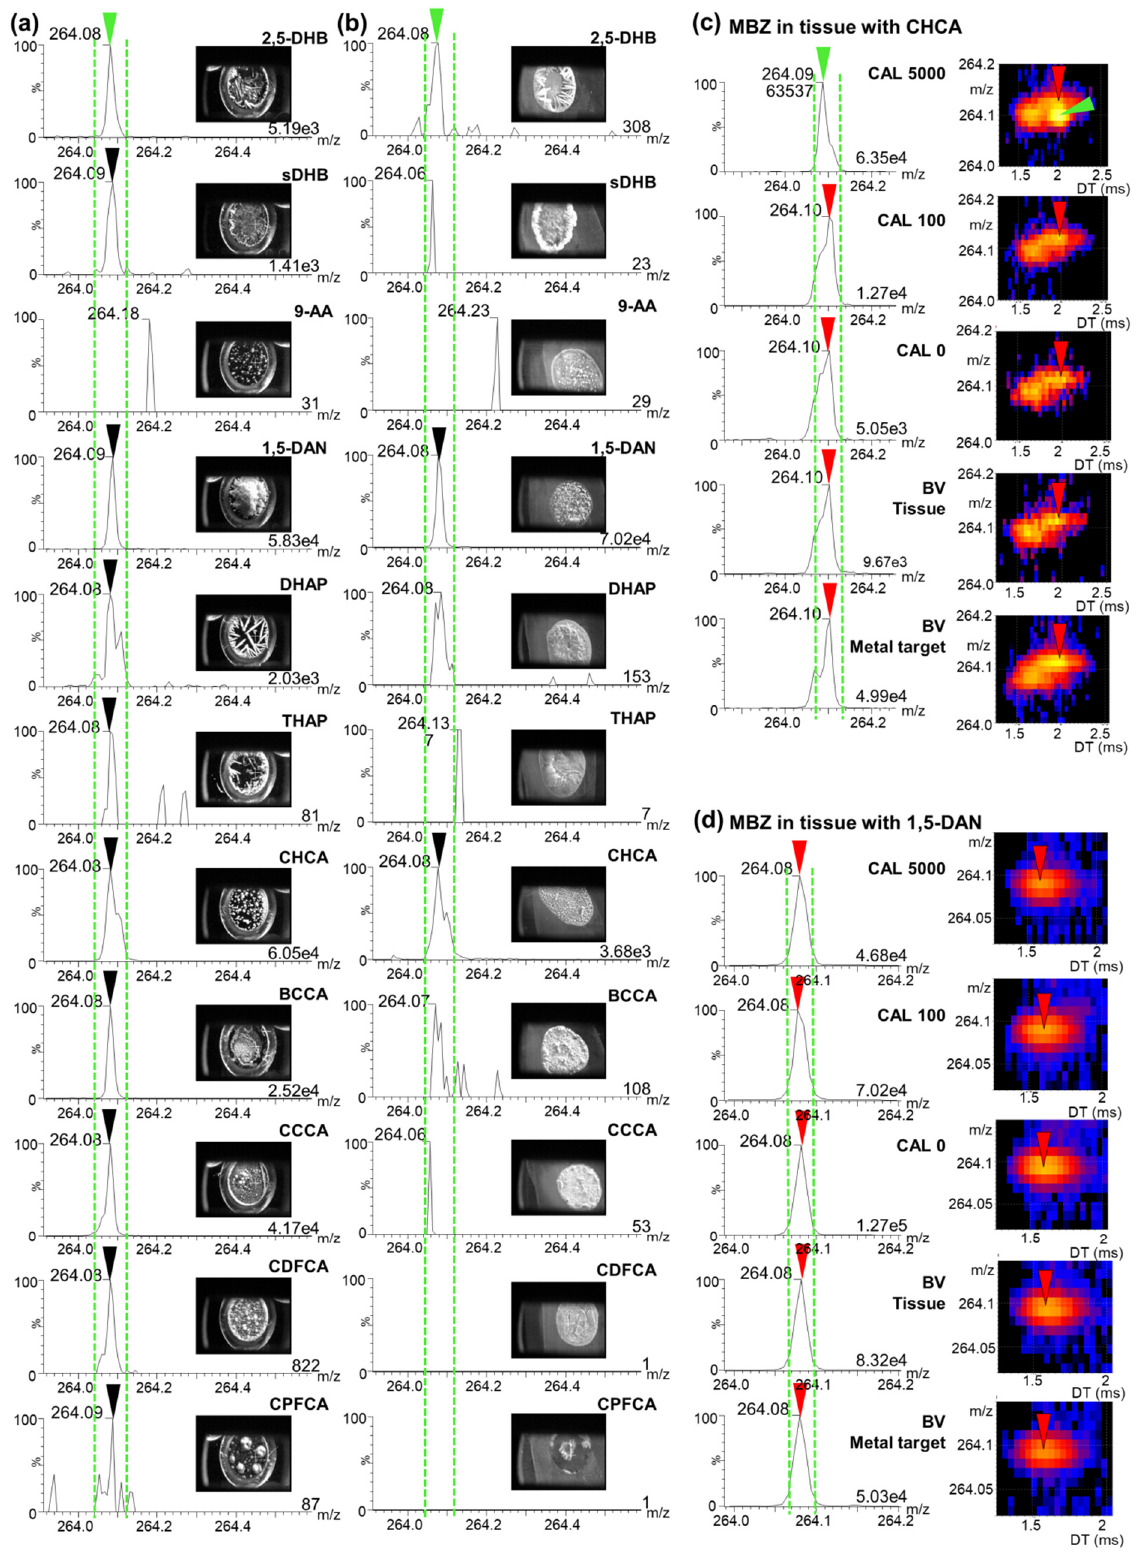
Figure 3. ( a ) Mass spectra of mebendazole (MBZ) calibration standard solution at 100 ng/g (CAL 100) were spotted on a matrix-assisted laser desorption/ionization (MALDI) metal target covered with different MALDI matrices. Spectra were acquired with automatic motion, showing the signal in the mass range of the fragment of interest of MBZ (green and black arrows, targeted mass window between green dotted lines). ( b ) Mass spectra of CAL 100 spiked on tissue sections with different MALDI matrices, showing the signal in the mass range of the fragment of interest of MBZ (green and black arrows, targeted mass window between green dotted lines) ( c ) Mass spectra and two-dimension (2D) mobility maps of